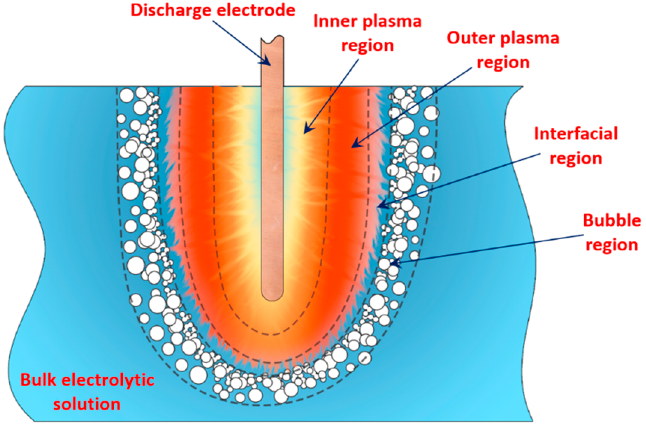
Figure 6. Illustration of the regions at the discharge electrode.